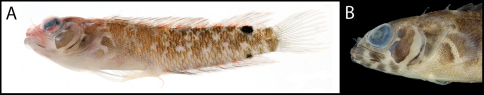
A Color pattern of Starksia springeri, USNM 399658, CUR 8148, paratype, 15.0 mm SL, male(?) B diagnostic pigment pattern on cheek and pectoral-fin base in preserved Starksia springeri, USNM 398945, holotype, 19.0 mm SL, female. Photographs by Carole Baldwin, Cristina Castillo, and Donald Griswold.